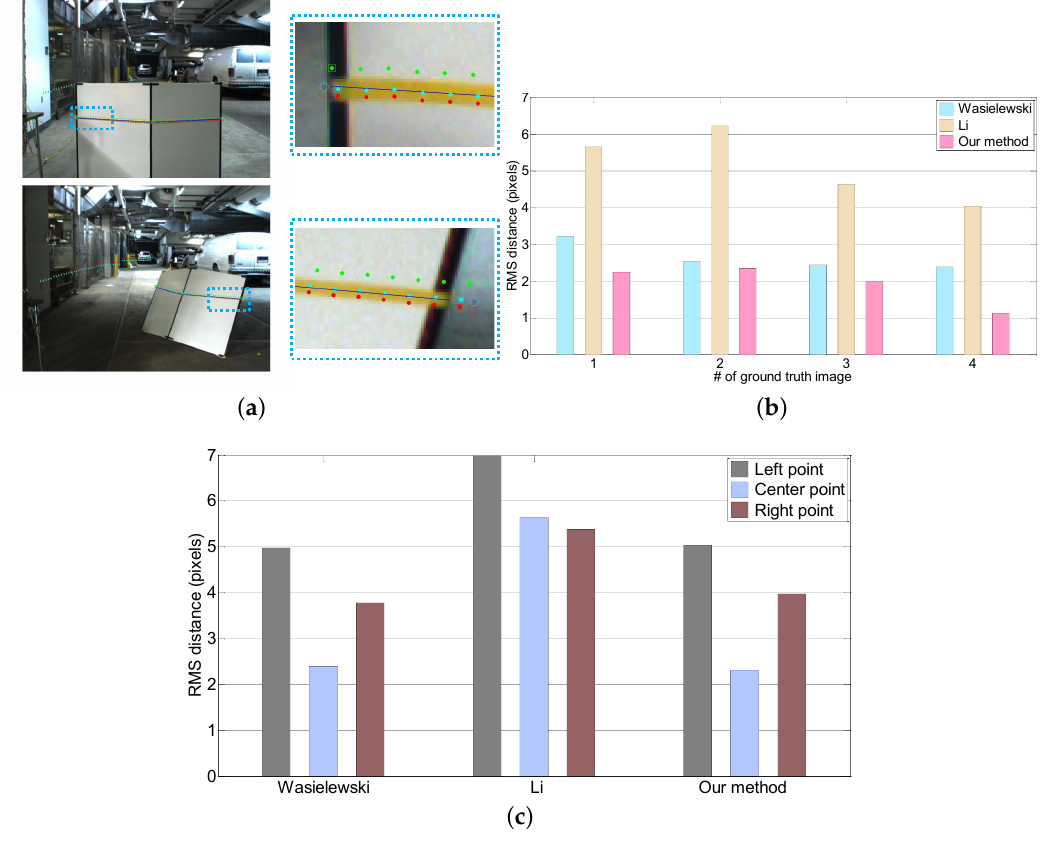
Figure 8. The comparison of the extrinsic calibration algorithms proposed by Walsielewski, Li and us. To do this test, we used the four ground truth images we made. ( a ) Projection of the LiDAR points onto the two ground truth images. The yellow band is the marked tape. The blue line is the mid-line of the marked tape that was manually selected. The cyan boxes show the close-up of the projection of the LiDAR points. Red points = Wasielewski; green points = Li; cyan = our method (robust); ( b ) Line alignment error between the ground truth line and projected LiDAR points; ( c ) Point correspondence error for the ground truth points and projected feature